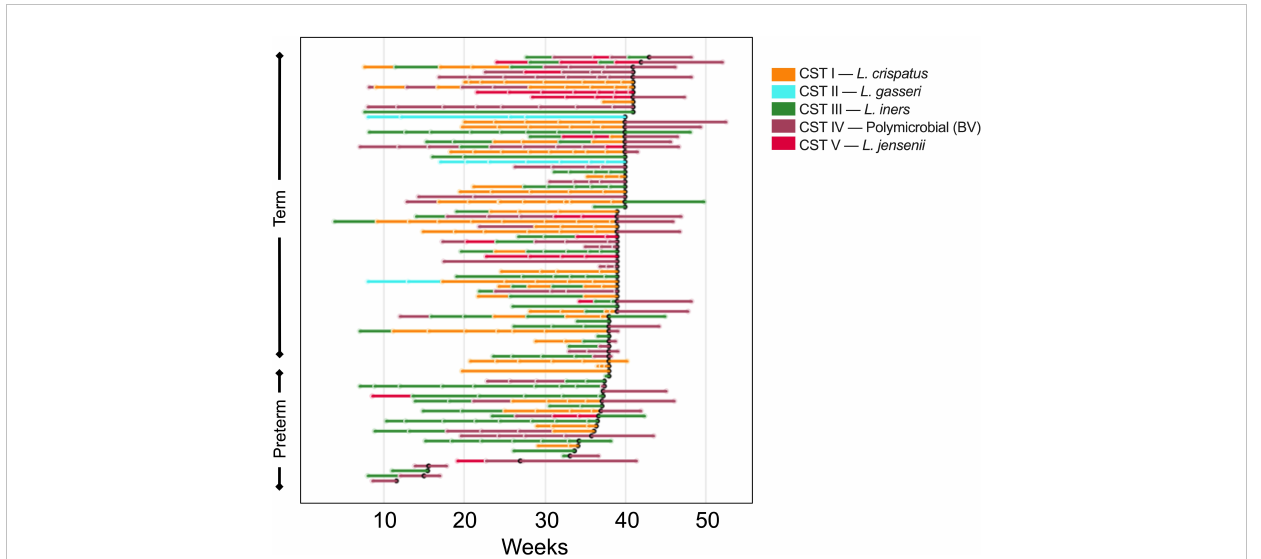
FIGURE 3 Changes in vaginal microbiome CST for each participant in the study over the course pregnancy. The lines are colored to correspond to the CST of the prior sampling, and each break in the line indicates a new sample. The bar color indicates the CST as shown in the key, where orange represents CST I, blue CST II, green CST III, purple CST IV, and pink CST V. The black dot represents time of delivery, and the lines following the black dot represent the postpartum sample.